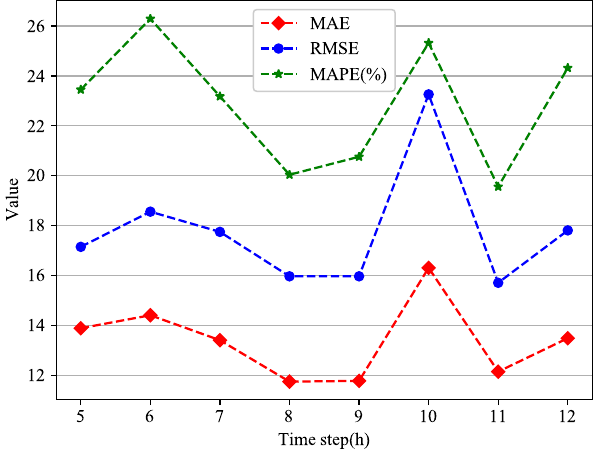
Figure 7. The experimental results corresponding to different time